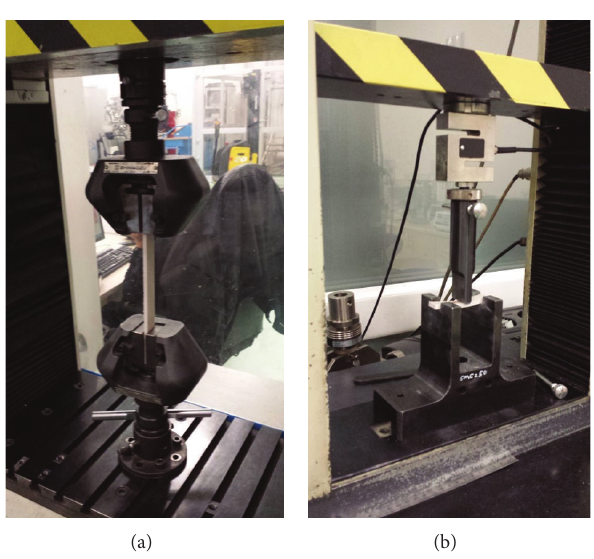
Figure 3: The specimens fixed the testing device (a) tensile and (b) flexural tests.